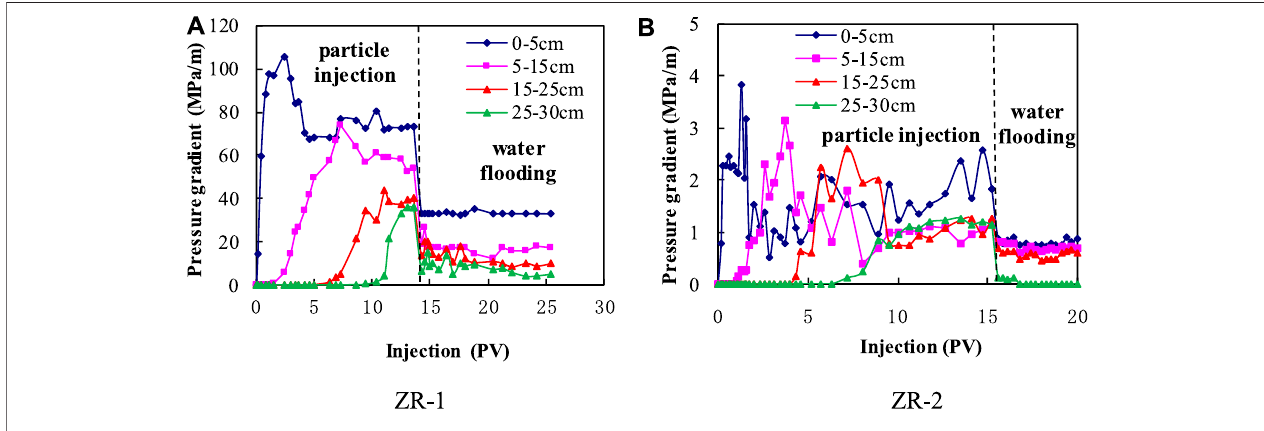
FIGURE 6 | Injection dynamics of the self-assembled particle in experimental